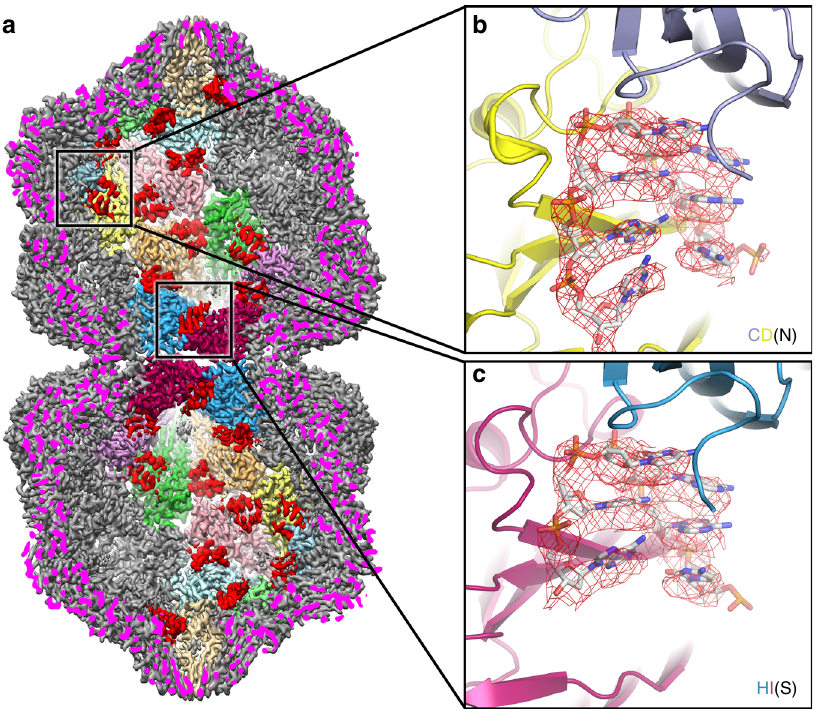
Fig. 4 Single-stranded DNA binding. a Rear half of the EM density for AYVV at 3.3 Å resolution. The cut surface of the EM density is colored bright magenta for clarity. Two D5 asymmetric units are shown at the back of the capsid (colored as in Fig. 1a). High-resolution density corresponding to ssDNA is in red. b The EM density for 7 nucleotides of DNA is shown as a red mesh and the modeled atomic coordinates for CPs C and D and DNA stem loop N (CD-type DNA) is shown. These 7 nucleotides and the mode of binding to the neighboring subunits is identical for the majority of the CPs (i.e. A-G & I-K). At the interface (i.e. CPs H and I) these interactions are different, c shows 6 nucleotides, stem loop S, and the neighboring CPs H and I (HI-type DNA), depicted as described in